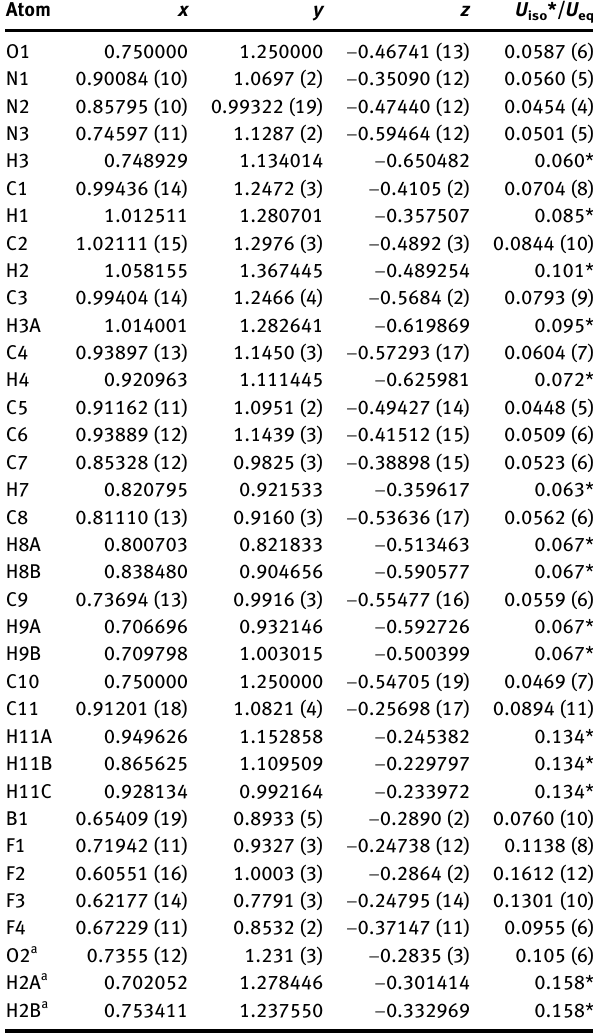
Table  : Fractional atomic coordinates and isotropic or equivalent isotropic displacement parameters (Å 